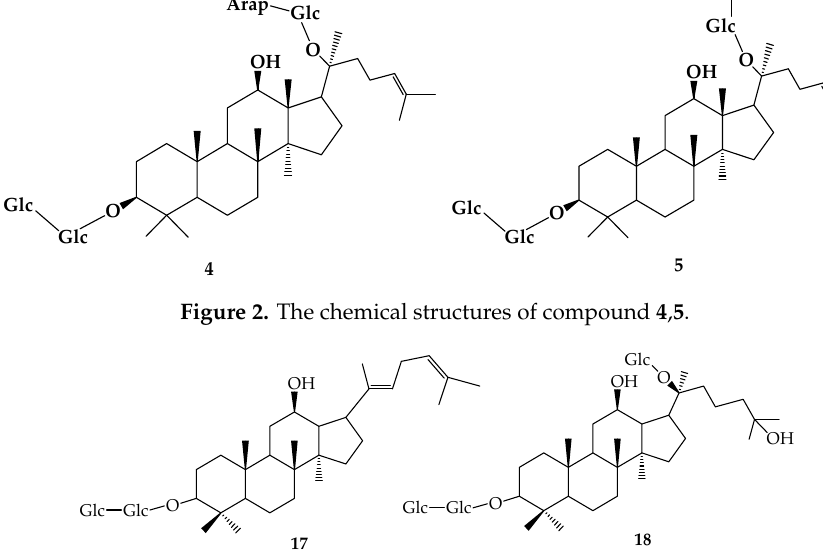
Figure 3. The chemical structures of compound 17 , 18 .